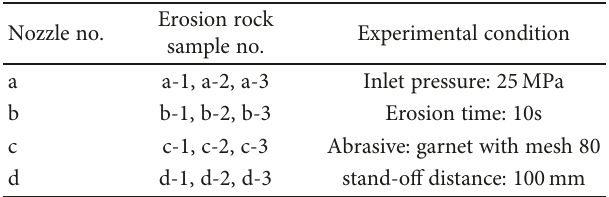
Table 8: Experiment procedure. Erosion rock Nozzle no. sample no.